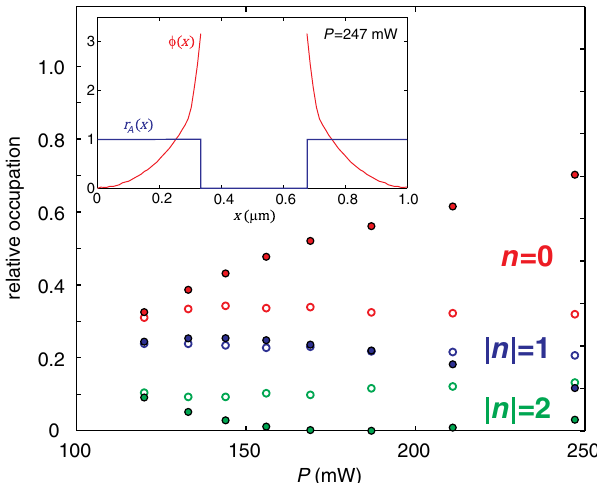
FIG. 5 Occupation of diffraction orders including phase im- printing (open circles) as compared to amplitude imprinting alone (dots). The deviation due to phase imprinting is increasing with the laser power. The inset shows the spatial dependence of the ð x Þ and the phase ϕ ð x Þ of the reflection function for amplitude r A a laser power of P ¼ 247 mW,